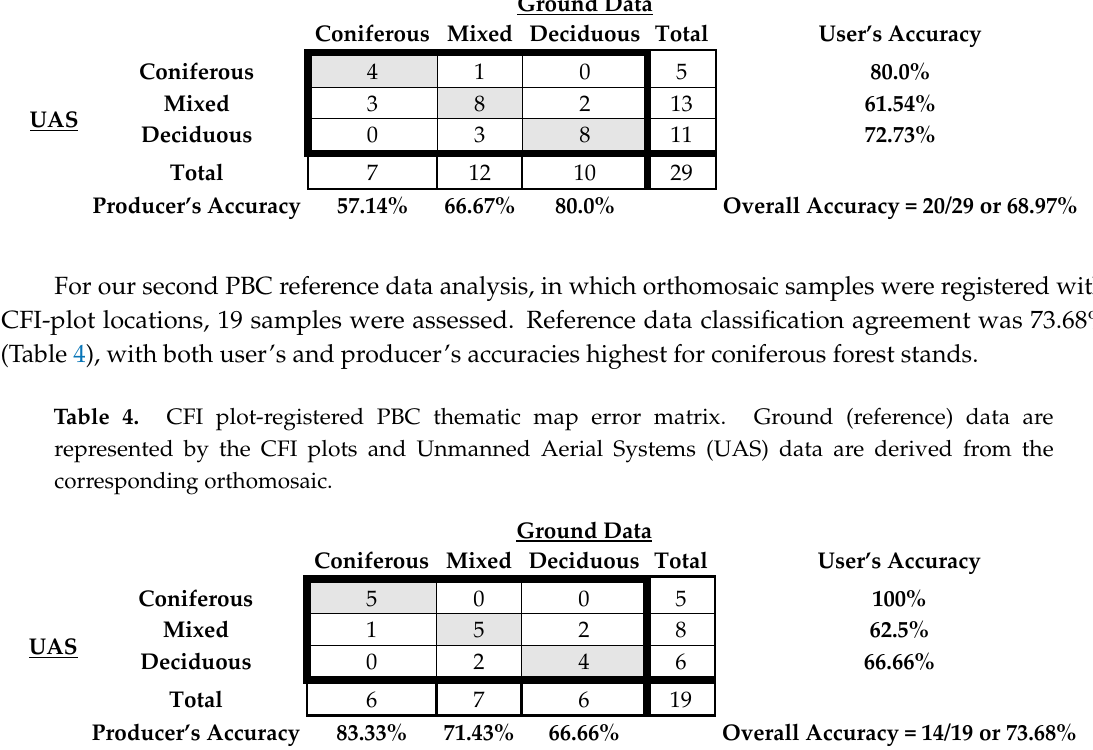
Table 5. Stratified randomly distributed OBC reference data subsample error matrix. Ground (reference) data are represented by the CFI plots and Unmanned Aerial Systems (UAS) data are derived from the corresponding orthomosaic.